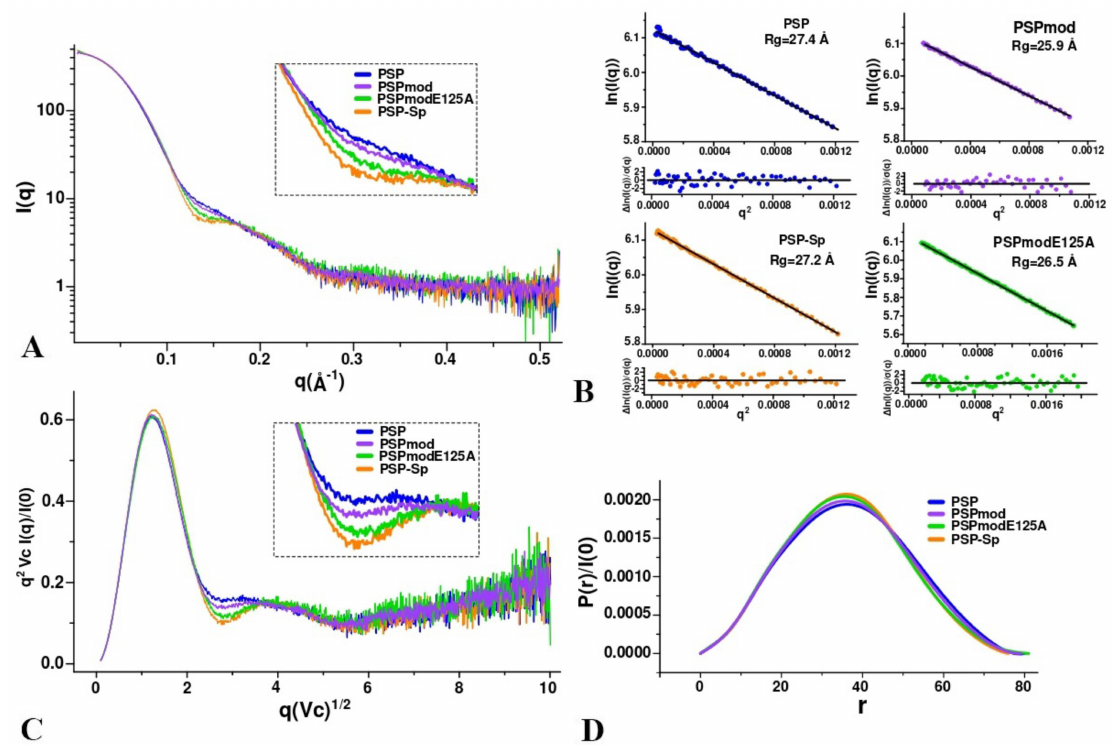
Figure 4. Analysis of SAXS data for various PSP derivatives. The experimental conditions are the same for all measurements (20 mM TrisHCl buffer, pH 8.0 and 100 mM NaCl, T = 20 ◦ C). ( A ) SAXS curves on a logarithmic scale (the inset shows the region with the highest deviation); ( B ) Guinier plot with linear fit; ( C ) dimensionless (normalized) volume-of-correlation(Vc)- based Kratky plots; ( D ) pair-distance distribution function profiles